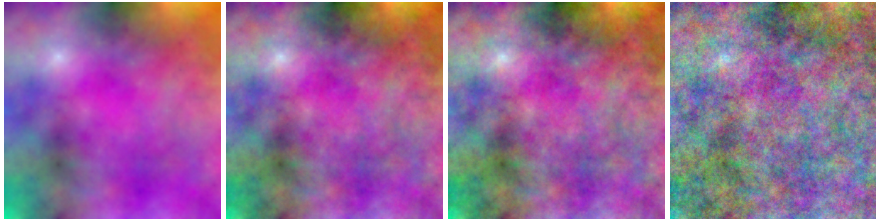
Figure 5. Texture complexity examples: natural textures ( Nat ) on first two rows ( a – g ) and synthetic fractal textures ( Frac ) last two bottom rows ( h – n